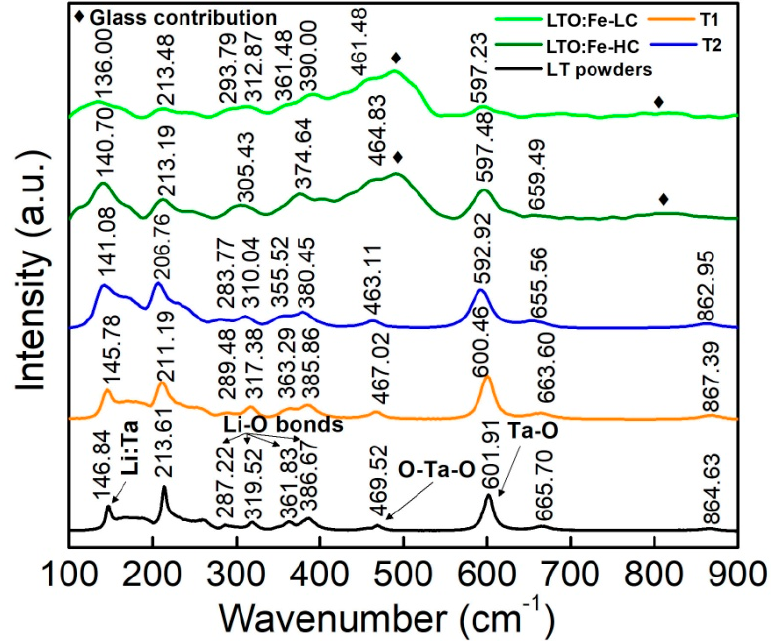
Figure 6. Raman spectra of the LT powders, T1, T2, LTO:Fe-HC, and LTO:Fe-LC samples. Recently, it has been demonstrated that the Fe dopant directly influences the vibrational modes A 1 (TO 1 ) and A 1 (TO 2 ) of the Raman spectrum of the LN, which, in turn, is associated with the Li–O − 1 − 1 bonds located at the wavenumbers of 257 cm and 276 cm , respectively [23,35]. As the doping concentration increases, these vibrational modes tend to broaden and merge, implying that the Fe ions substitute into the regular Li sites, strongly influencing the Li–O bond in the LN lattice. This behavior has also been reported by Bachiri et al. for Ni-doped LN [39]. In another case, Fierro et al. found—by − 1 − 1 RS—that the bands located at the 265 cm and 334 cm frequencies (linked to Li cation displacements) broaden as the Fe concentration increases, which has been interpreted as a substitution of Fe in Li positions for Fe-doped LN NPs [34]. In our case, the similarity in the observed trends indicates that the Fe ions directly influenced Li–O bonds in the crystal lattice of LT. The above-mentioned discussion can be understood in terms of the mechanism of Fe incorporation into the LN structure reported by Li et al. [23]: as V Li sites become occupied by Fe ions, Ta Li antisites are created, forcing ions of Ta to occupy its original site. After this, the Fe ions start to interstitially fill the surface of the film until they reach a high atomic percentage. The changes observed in the Raman spectra (broadening of bands) of Figure 6 were progressive as the number of intrinsic and extrinsic defects increased. Hence, the crystallinity of the thin films is directly a ff ected, in agreement with Fontana and Bourson, who reported the influence of extrinsic defects on the crystallinity of LN [36]. The LTO:Fe-HC presented a regular morphology,